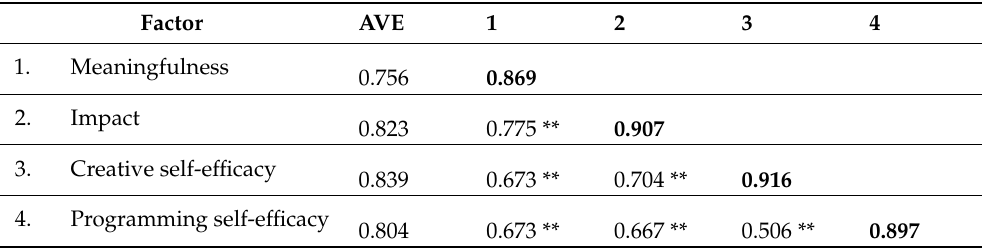
Table 5. Average variance extracted, square root of AVE, and matrix of correlations between factors for PES.